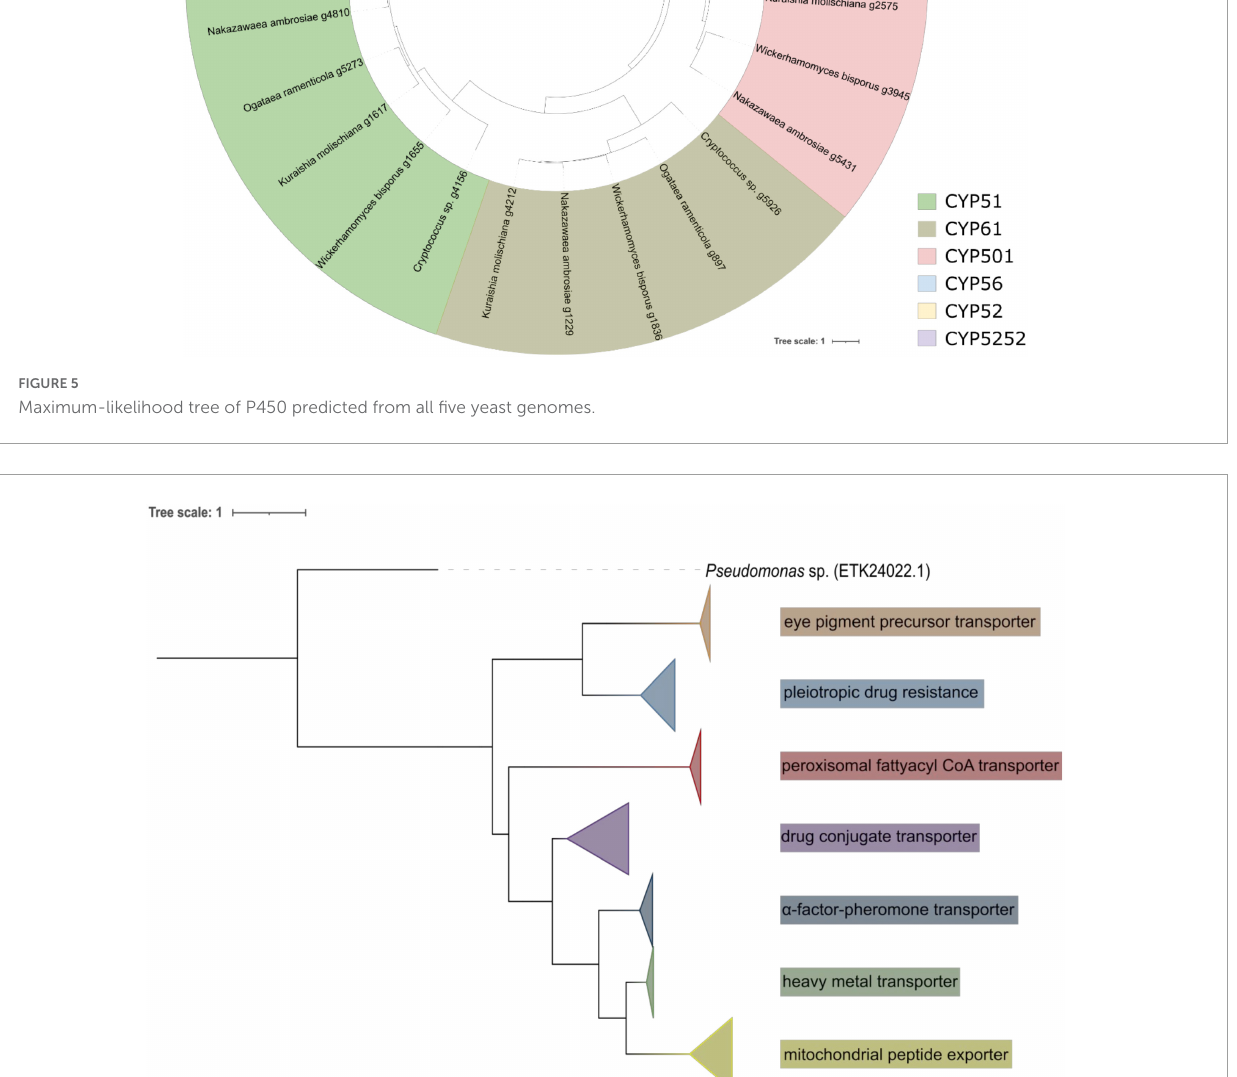
FIGURE6 Maximum-likelihood tree of ABC transporter predicted from all five yeast